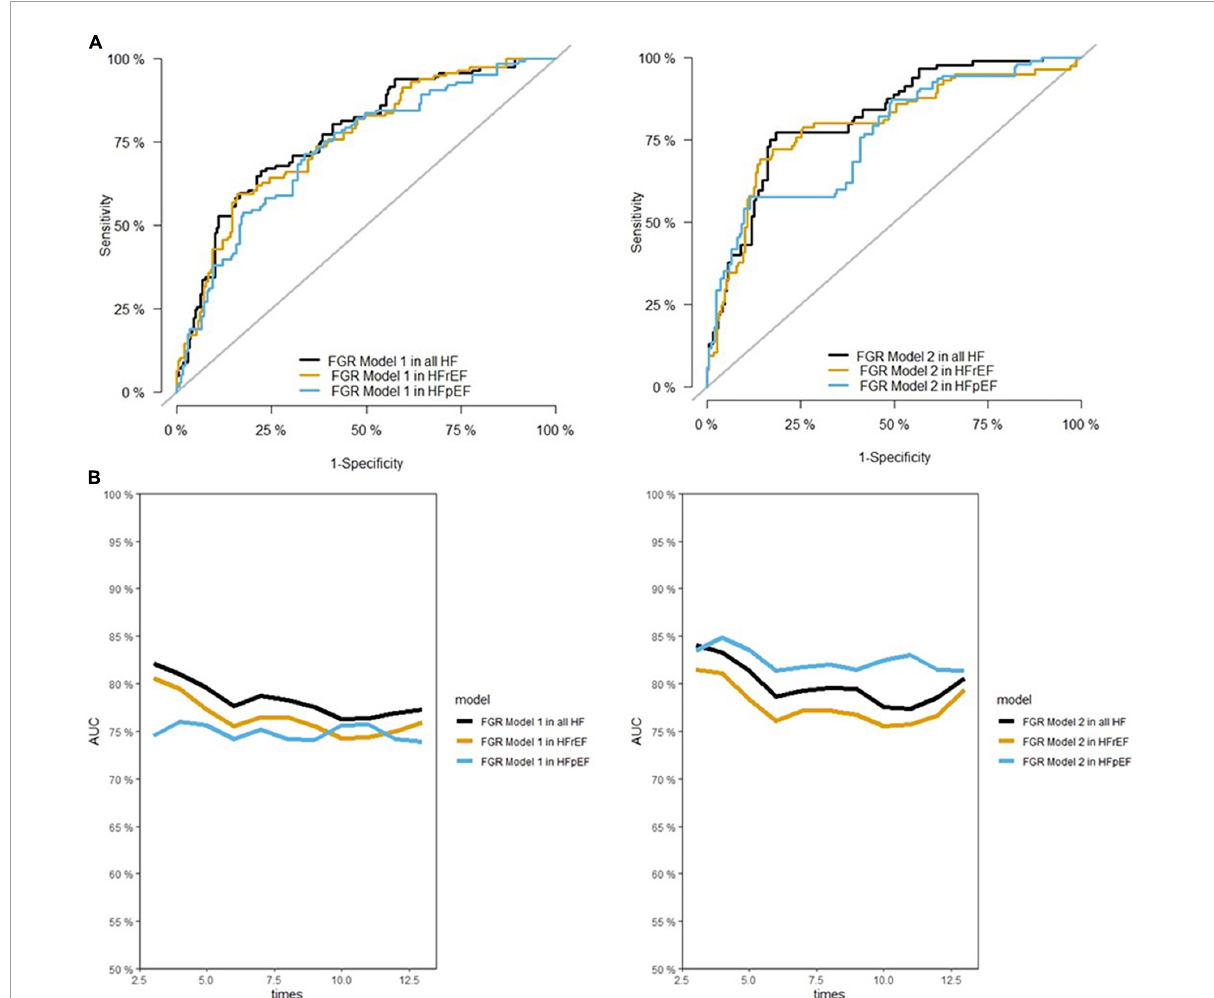
FIGURE3 Area under the ROC (receiver operating characteristic) curve (AUC) for different models at maximum time of follow-up (A) , and during the follow-up (B) . FGR, fine-gray regression. As illustrated in panel (B) , the AUC of models were acceptable during the entire follow-up